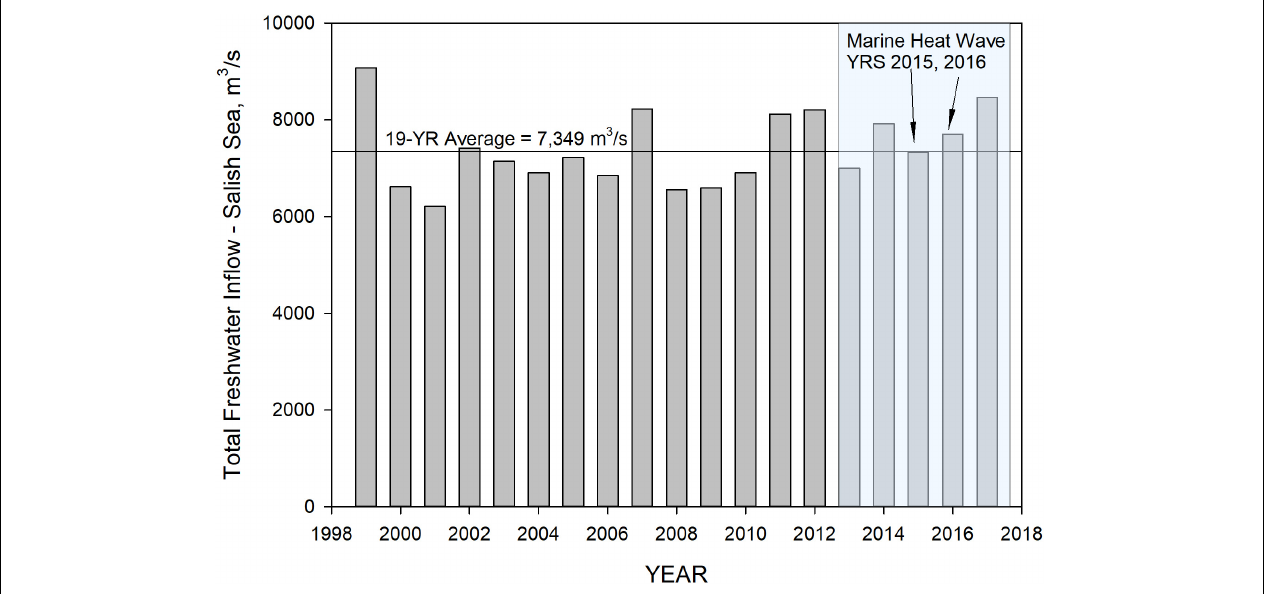
FIGURE 6 | Summary of annual average inflows into the inner Salish Sea covering Georgia Basin, Puget Sound, and the northwest straits surrounding San Juan Islands and the Strait of Juan de Fuca. The shaded region represents the study period from 2013 to 2017, and the peak marine heatwave years 2015 and 2016 are